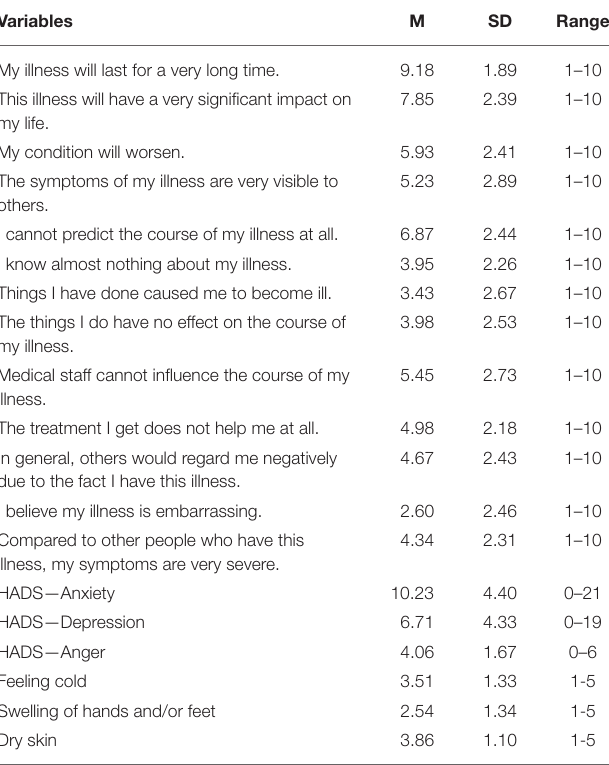
TABLE 1 | IRBQ and HADS-M descriptive statistics. Variables M SD Range